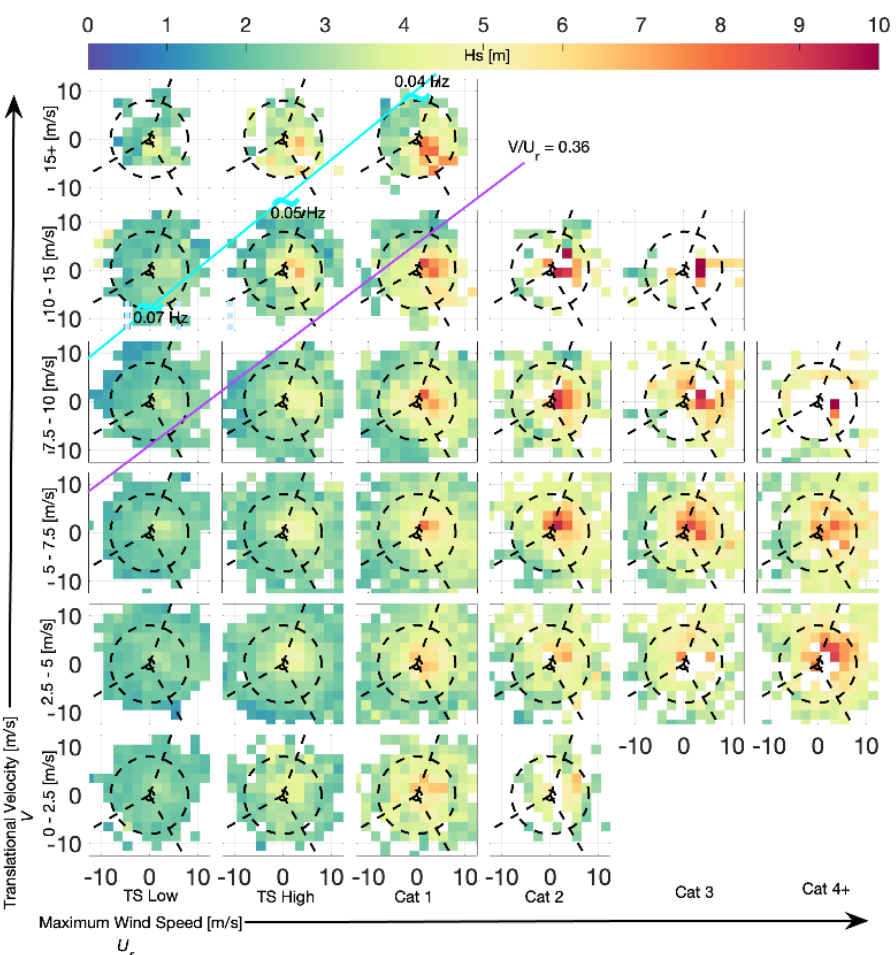
Figure 4. Altimeter observed wave height shown in color. Each subplot as in Figure 3 without interpolation or contour lines. Data are binned by S-S category from left to right. From bottom to top, data are binned by TC translation velocity. The color scale indicates significant wave height from 0–10 m. The cyan line shows the approximate correspondence of linear wave phase speed (x-axis) to group speed (y-axis). The wave frequency is given at 3 locations along the line. The purple line is the approximate location of the resonance condition of Kudryavtsev et al.,